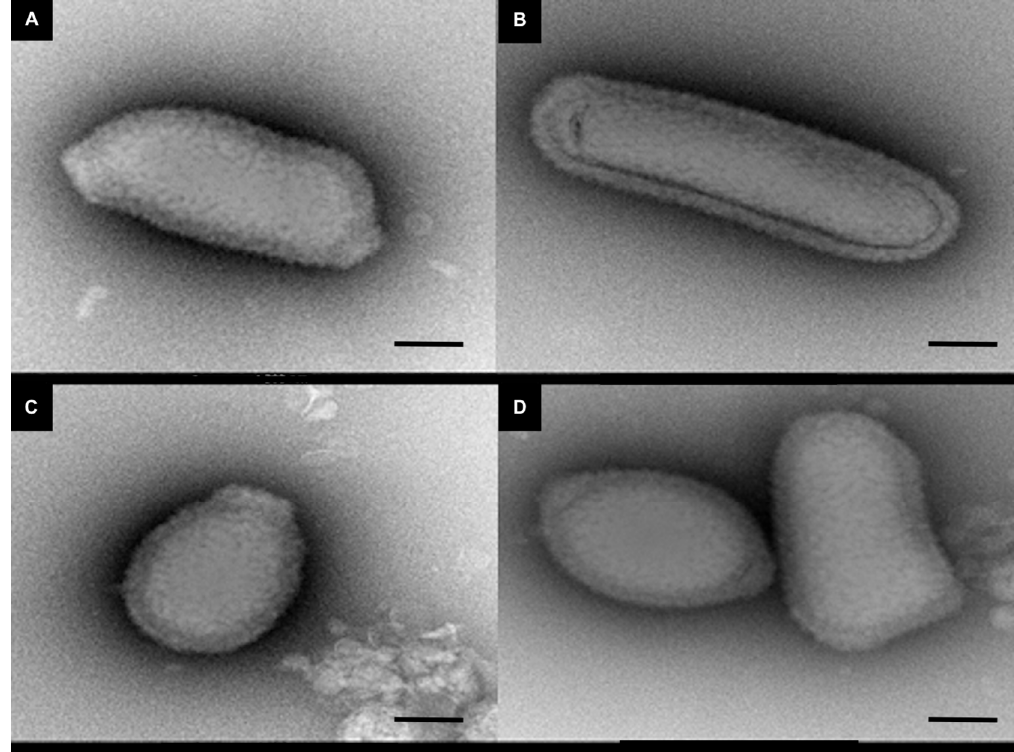
Figure 2. NegativestainingofcedratvirusN38particles. Blackscalebarindicates200nm. ( A ),( B ),( C )and( D ) Figure 2. Negative staining of cedratvirus N38 particles. Black scale bar indicates 200 nm. ( A ), ( B ), ( C ) show different forms of cedratvirus-like N38 isolated from Chlef and ( D ) show different forms of cedratvirus-like N38 isolated from Chlef City.